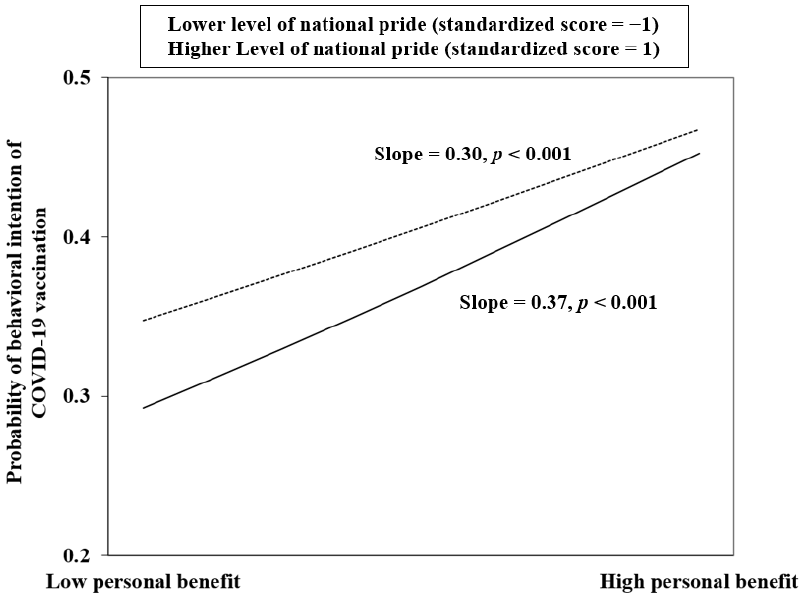
Figure 1. Graphical representation of significant interaction effect of perceived personal benefits × National pride onto behavioral intention of COVID-19 vaccination.